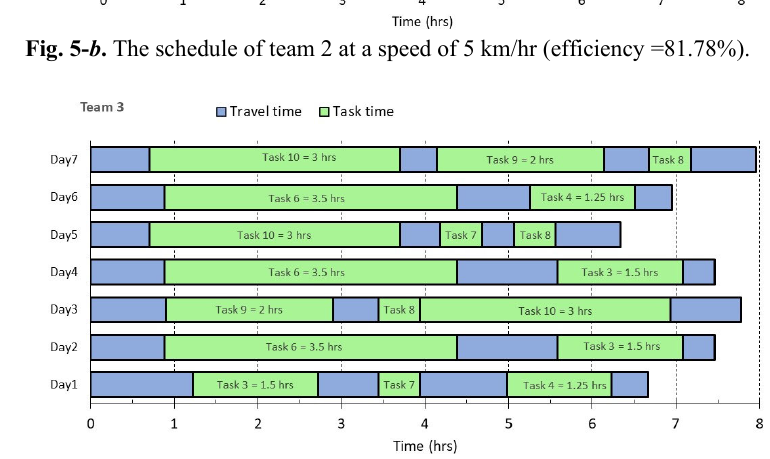
Fig. 5- c . The schedule of team 3 at a speed of 5 km/hr (efficiency